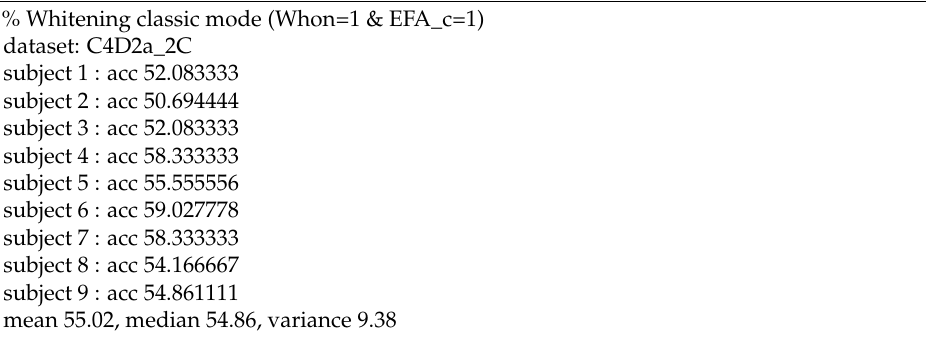
Figure 7a,b present the covariance matrix of C4D2a_2C for the first subject when the EFA method was applied. Figure 7c,d depict the covariance matrix of C4D2a_2C for